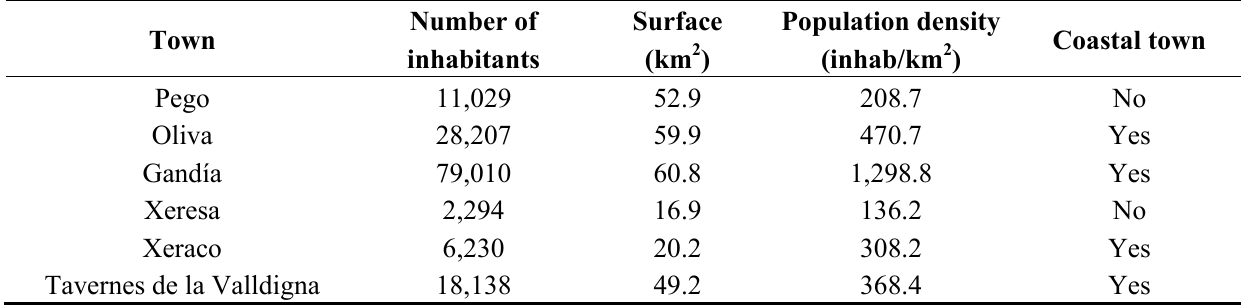
Table 1. Characteristics of case study towns in year of 2012. Data source: municipal records of the Valencian Institute of